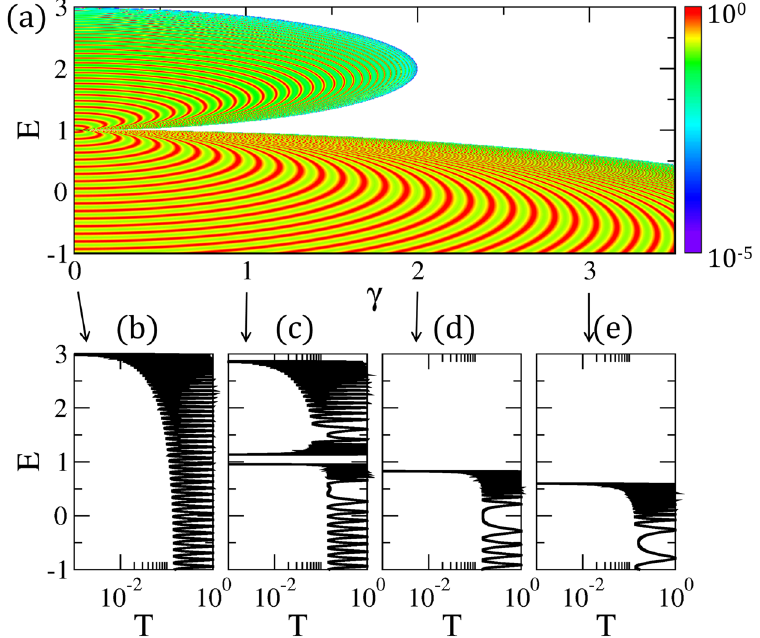
where | r 0 | 2 and | t 0 | 2 are reflection and transmission probabilities, respectively, with | r 0 | 2 + | t 0 | 2 = 1 in PT -symmetric cases. Using e E V , we obtain transmission probabilities from the resulting (2 N + 2) × (2 N + 2) matrix, where E is the incident energy from a lead 32 (see Supplementary Information II). In Fig. 2(a), the transmission probability T = | t 0 | 2 is oscillating as a function of energy E , and balanced gain and loss γ and the oscillation peaks are indicated resonances with eigenenergies as shown in (b–e). There exists trans- mission suppression, which makes the boundaries the same as the band edges for the unbroken phase in Fig. 1(a). Figure 2(b) shows the transmission probability without imbalanced potentials, which clearly corresponds to the dispersive bands of Fig. 1(b) because the compact localized states in the flat band are such that they are unavaila- ble for charge transfer. For all cases, the transport phenomena reflects the real eigenenergies of the lattice. Regarding transmission, it is striking that the broken PT -symmetric phase does not contribute to charge transfer in any energy range, including E = t , which is flat band energy when γ = 0. Consequently, transport is determined by the unbroken phase, having only real energy bands; transport is not determined by the broken phase, even though the complex energy bands are dispersive, as seen in Fig. 1(c–e). It is noteworthy that the behavior of band width depending on balanced gain and loss is totally distinct from precedent bandgap engineerings 33 . The band width narrows as γ increases, until all states of the upper band disappear in transmission probability. After the critical value γ > γ c , the transmission is suppressed above the remaining lower energy band. The suppressed region is separated by unmeasurable and forbidden regions, which either include resonant states or not, e.g., in the cases of ε r < ε c and ε r > ε c , respectively. Besides variations in the bandgaps, the resonant levels near the EPs are quite different from those near the band edges. The level spacings are large near the EPs, while the resonant levels are dense near the band edges; this originates from the density of states being inversely proportional to the group velocity, D ( ε ) = D ( k )/( d ε / dk ). As seen in Fig. 1(c–e), the group velocity is diverging close to the singular EPs and converging to zero close to the band edges. Thus, at the EPs, there is no resonant transmission through a lattice with a finite number of sites. In addition, the shifts of resonant energies near the EPs are very sensitive to perturbations.